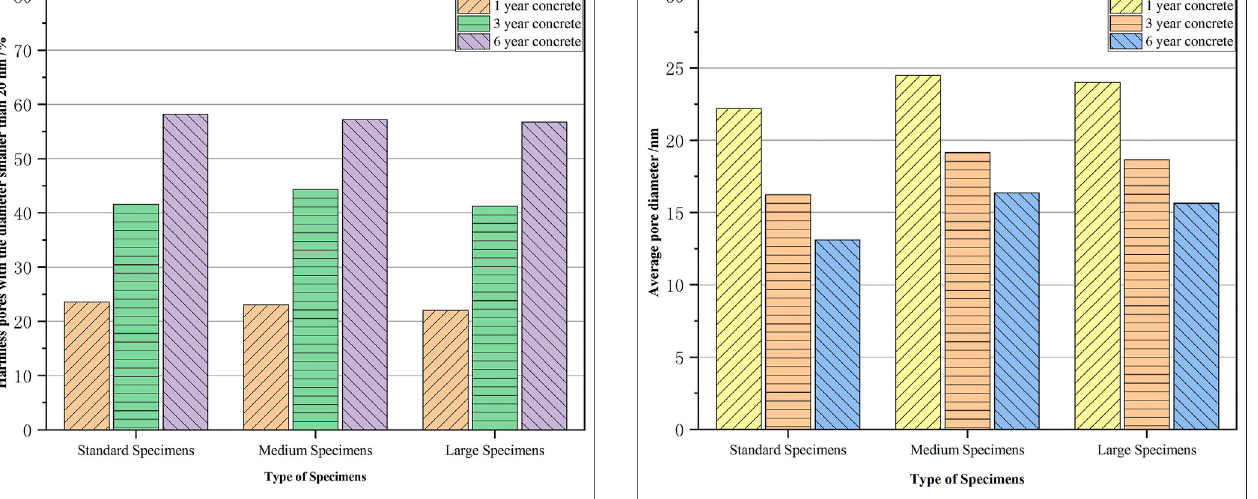
FIGURE 11 | Average pore size of concrete mixed with 6% MgO.